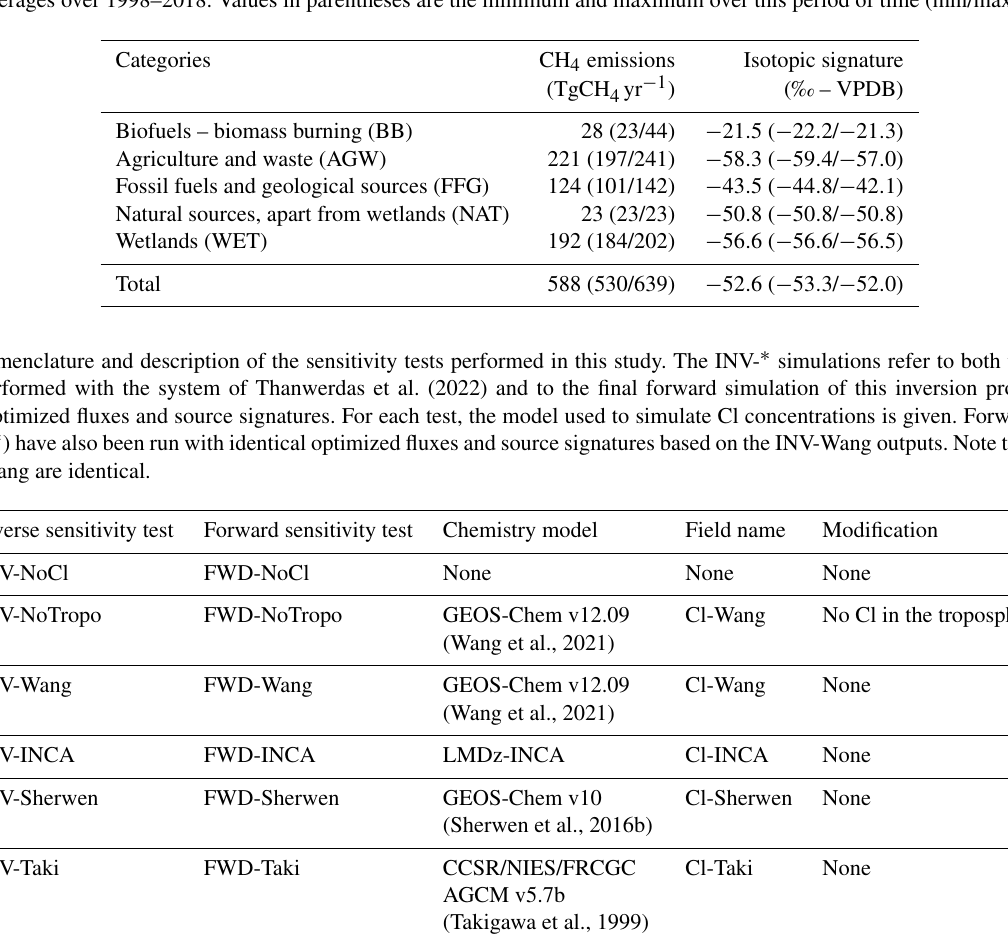
Table 2. Global CH 4 emissions and associated flux-weighted isotopic signatures by source category obtained with INV-Wang. The given values are averages over 1998–2018. Values in parentheses are the minimum and maximum over this period of time (min/max).